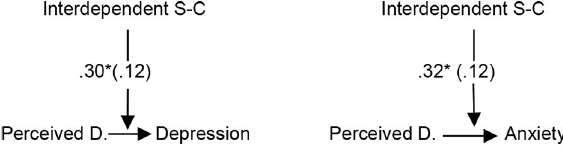
Note . Perceived D. = Perceived Discrimination; S-C = Self-Construal.